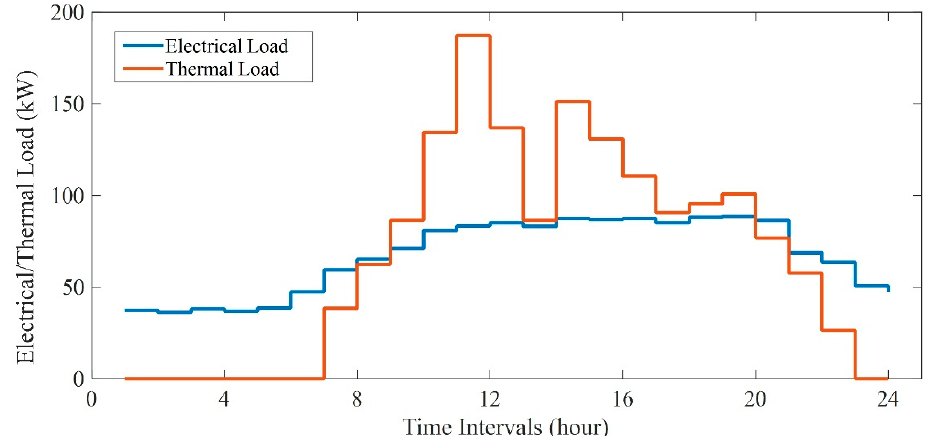
Figure A6. Electric/Thermal load curve for each period on the typical winter day.